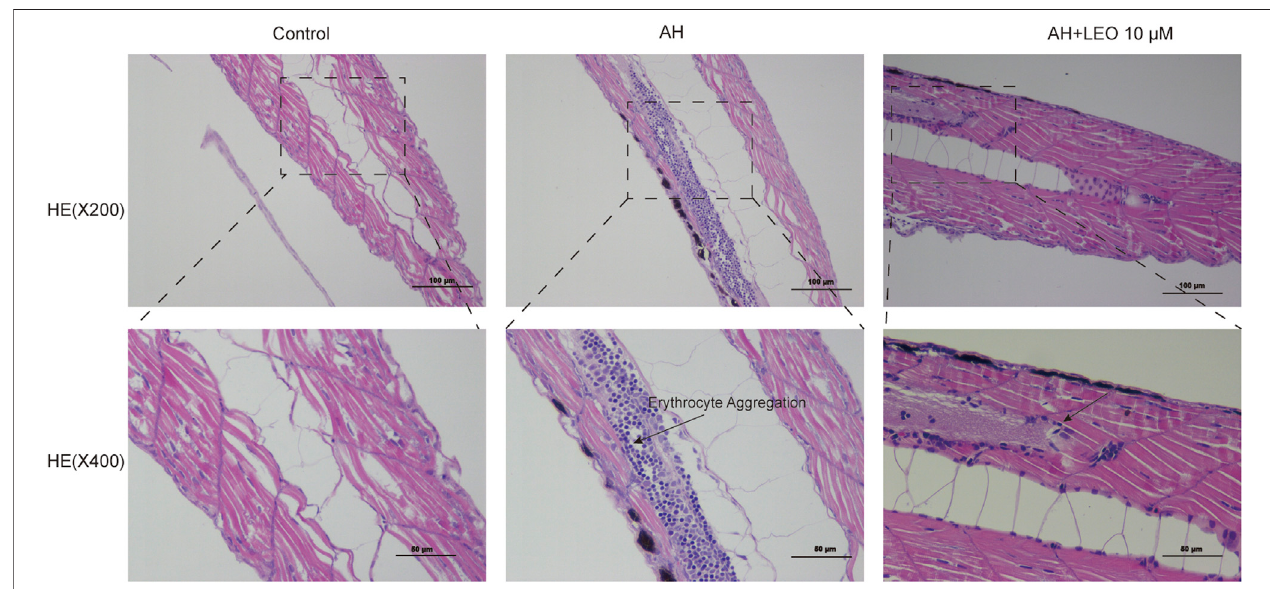
FIGURE 7 | Effect of LEO on the H&E staining of tail vein in zebra fi sh larval ( × 200 and × 400). The blue dots represent erythrocyte.